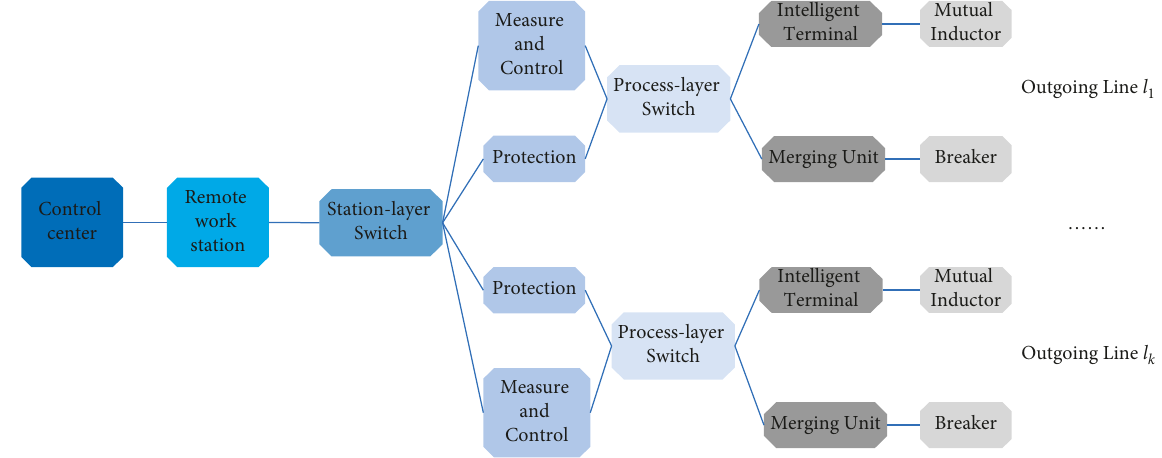
Figure 7: Communication network of substation monitoring